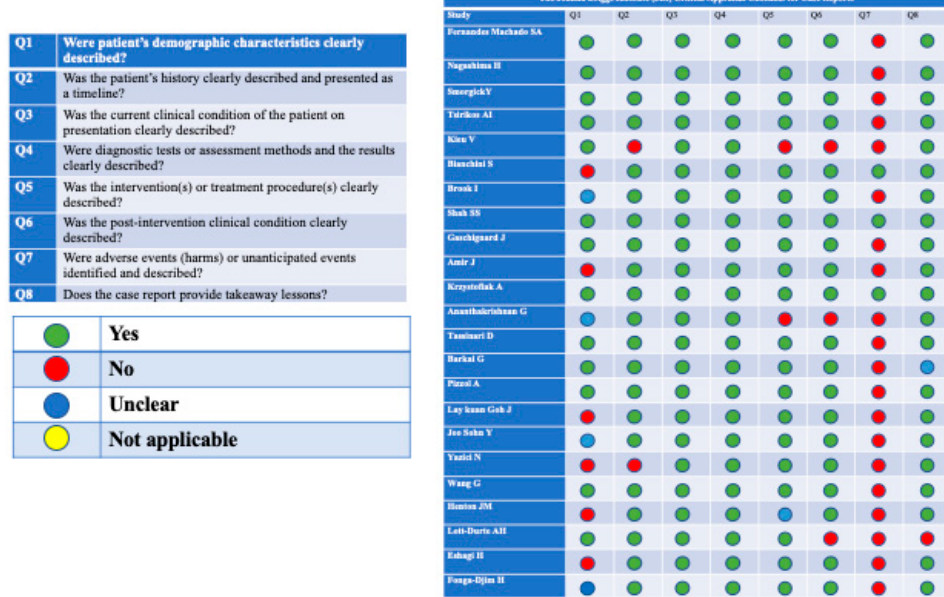
Figure 2. Quality assessment of the included studies. The Joanna Briggs Institute (JBI) Critical Appraisal Checklist for Case Reports.